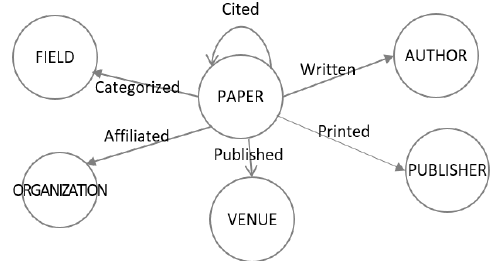
Figure 2. Conceptual Model of Bibliographic